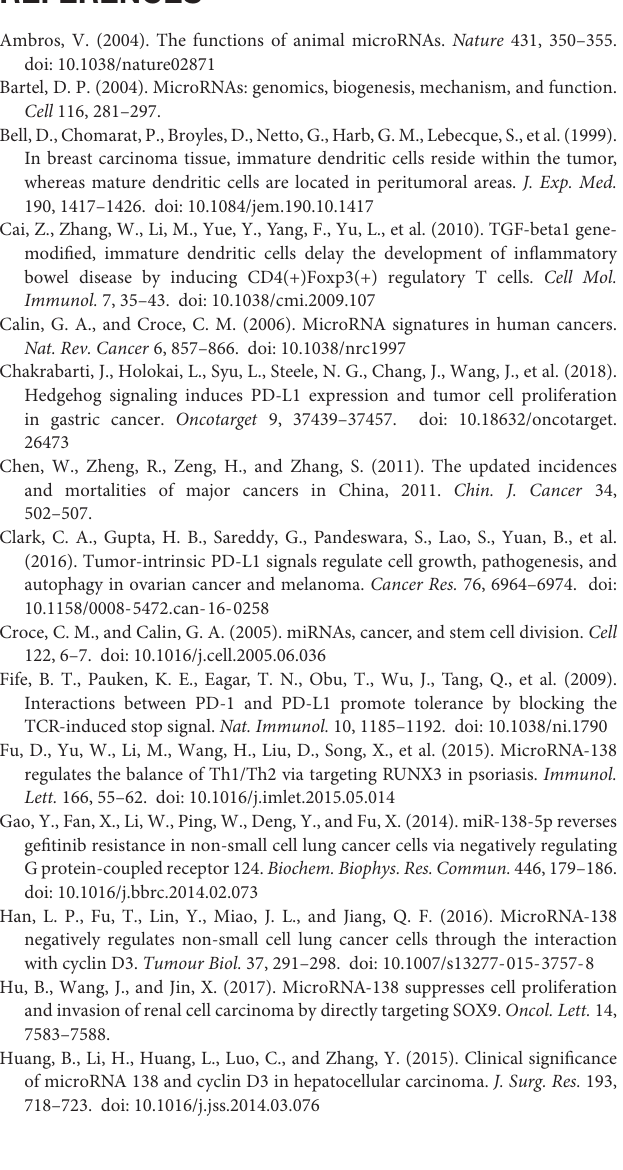
FIGURE S5 | MiR-138-5p treatment decreases the mRNA expression levels of VEGF, TGF- β , eNOS, PGE2 and IL-10 in A549 tumor (A) , 3LL tumor (B) , A549 (C) and 3LL cells (D) . FIGURE S6 | MiR-138-5p treatment decreases the mRNA and protein expression levels of PD-L1 in 3LL cells. FIGURE S7 | With lent-miR-138-5p treatment, or lent-N treatment, or not, the level of PD-1 and PD-L1 expression on isolated DCs. FIGURE S8 | shRNA PD-L1 influence proliferation of 3LL cell. FIGURE S9 | The design map of our manuscript. FIGURE S10 | The diagram of the effect of miR-138 on tumor cells and DCs. TABLE S1 | With lent-miR138-5p treatment or not, the mRNA expression levels of molecules related to growth and immune regulation in A549 tumor cells by cancer pathway Finder PCR array and showed in